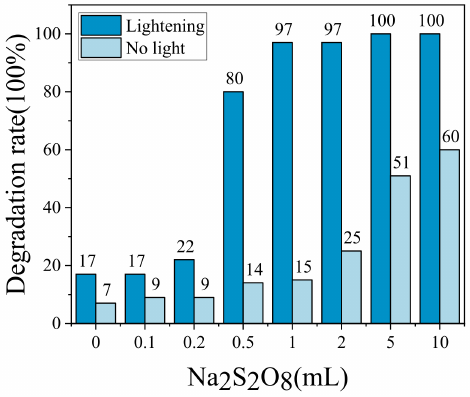
Figure 6. Effect of different amounts of Na 2 S 2 O 8 on the degradation rate of Rhb.